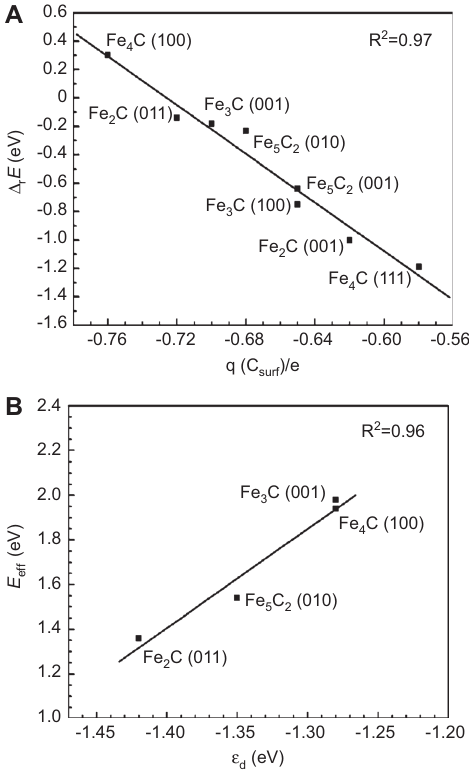
E ) of CH r 4 ) of the d